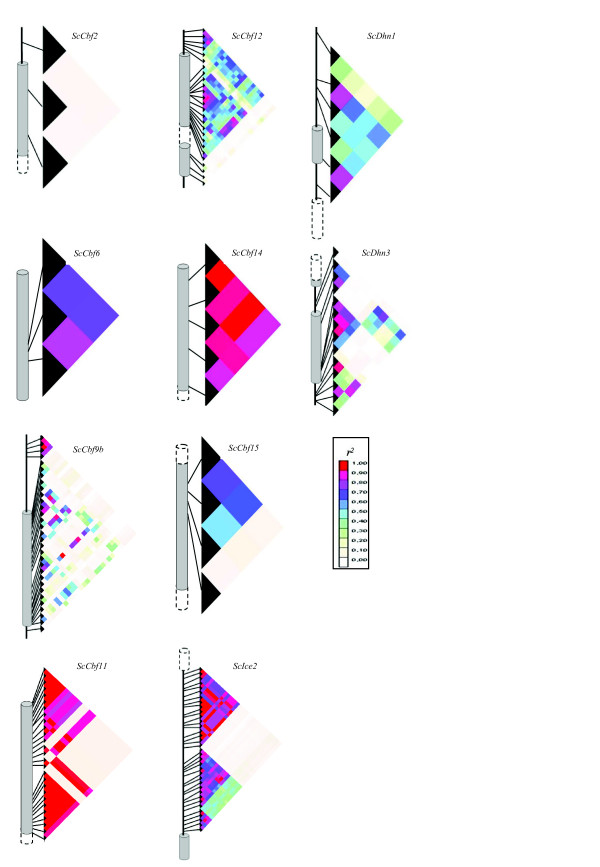
LD heat plots of ten candidate genes. Analysed sequences, including the promoter and complete coding sequences of ScCbf6 and ScCbf9b, and partial coding sequences of ScCbf12, ScCbf14, and ScCbf15; ScVrn1 was not included due to a lack of pairwise comparisons, since only one Indel was observed. Exons, and 5'- or 3'-flanking regions are represented by grey cylinders and black lines, respectively. White cylinders with dashed lines indicate non-amplified exons. Black triangles represent polymorphic sites starting from "SNP1" on the top of each graph. Each grid represents the strength of LD estimated by r2 for each pairwise comparison between polymorphic sites with a minor allele frequency (MAF) > 0.05. The colour legend for r2 values is given on the right side.